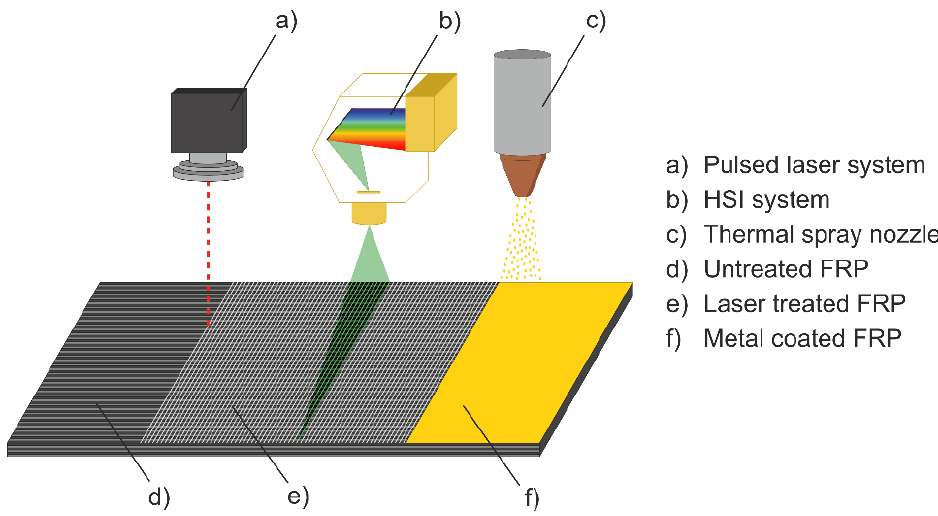
Figure 1. Process chain from untreated CFRP to laser structured surface and to coated surface including laser system, quality control by HSI system, and metallization by thermal spraying.